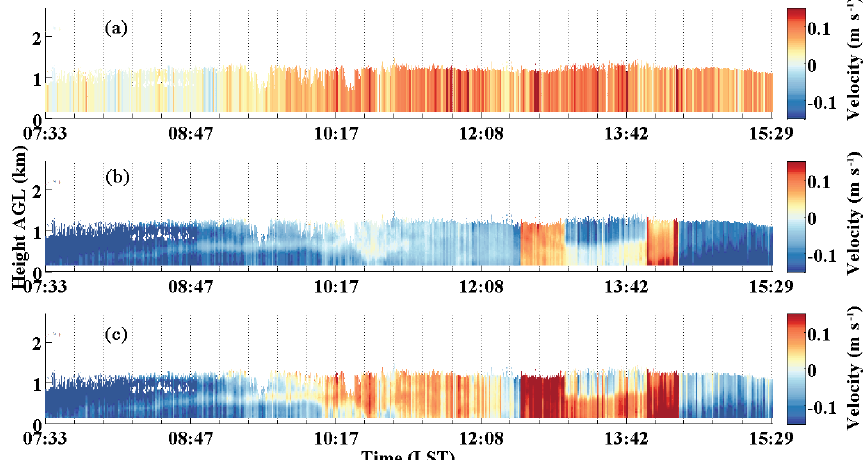
−→ V LOS_ship , (b) the effect of horizontal